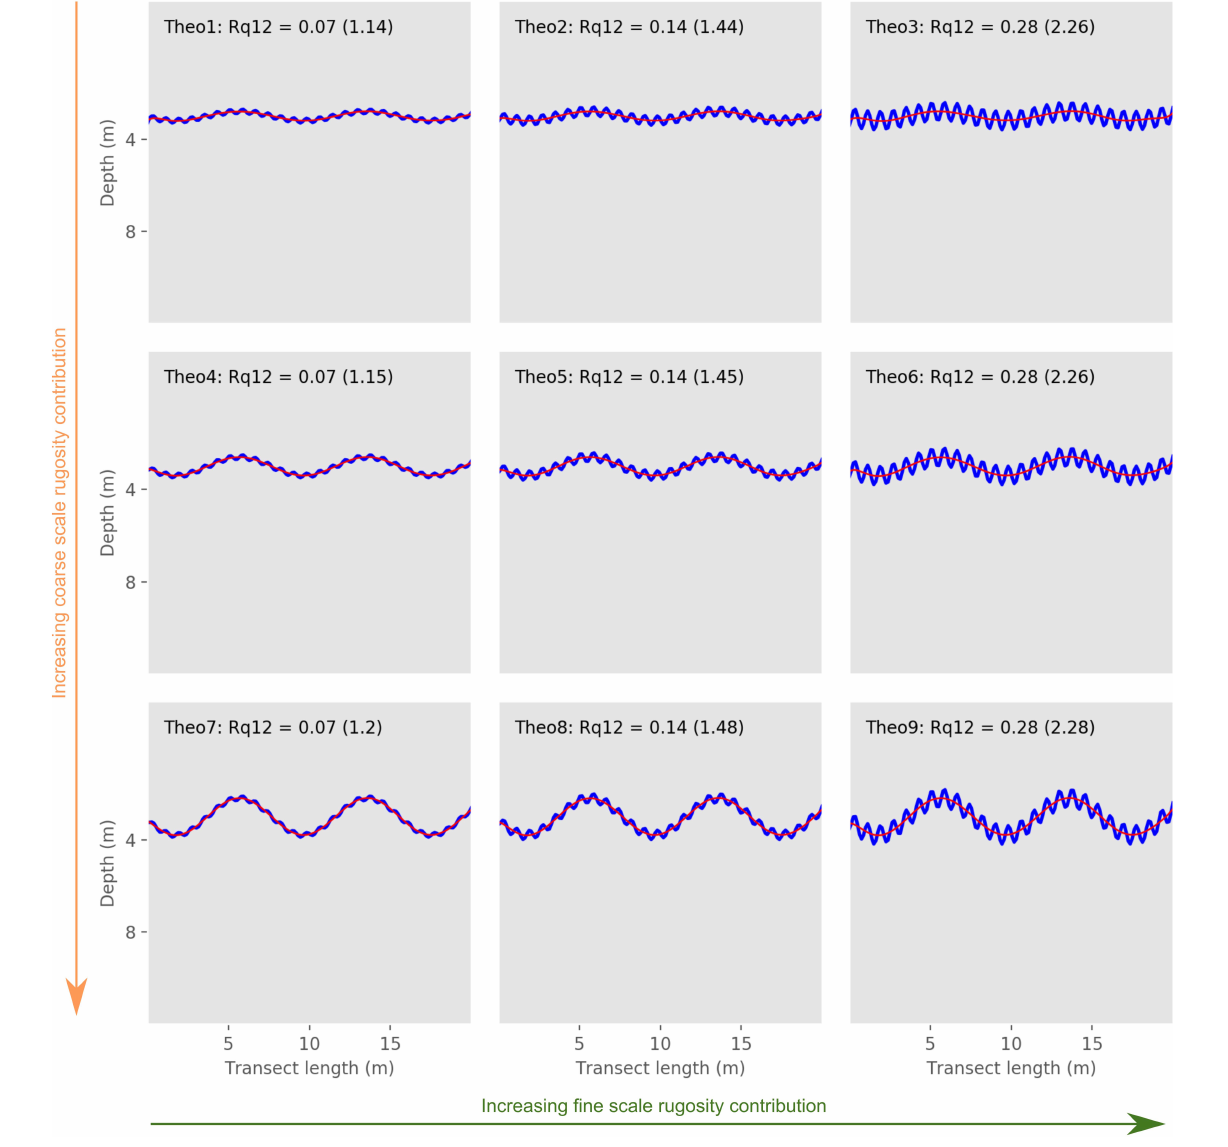
FIGURE 3 | Depth profiles of the theoretical transects along with their twelfth order of polynomial. Elevation profiles (blue lines) for each transect. Red lines represent the twelfth order polynomials. Chain index results are reported in parentheses; the orange and green arrows represent the increasing gradients of coarse and fine scale rugosity, respectively, between